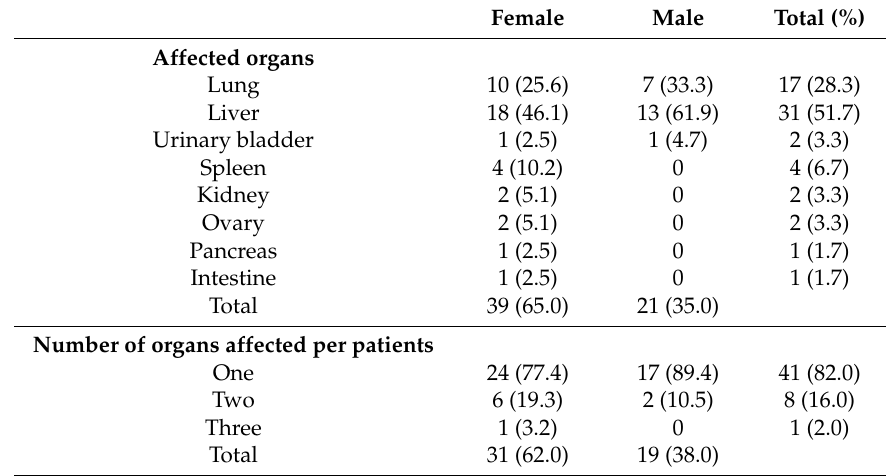
Table 1. Anatomical sites of hydatid cysts as reported by the patients ( n = 50).